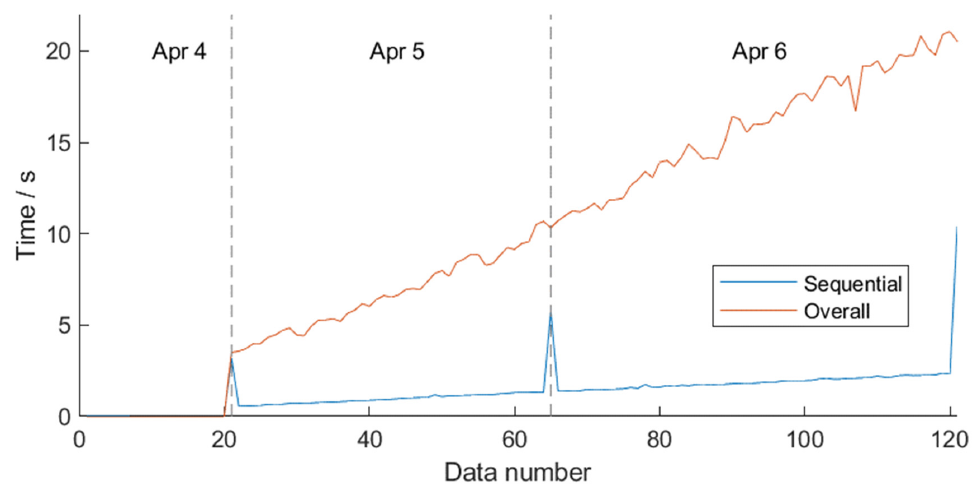
Figure 10. Continuous appending data, additional time consumed with sequential estimation, and least squares overall estimation.